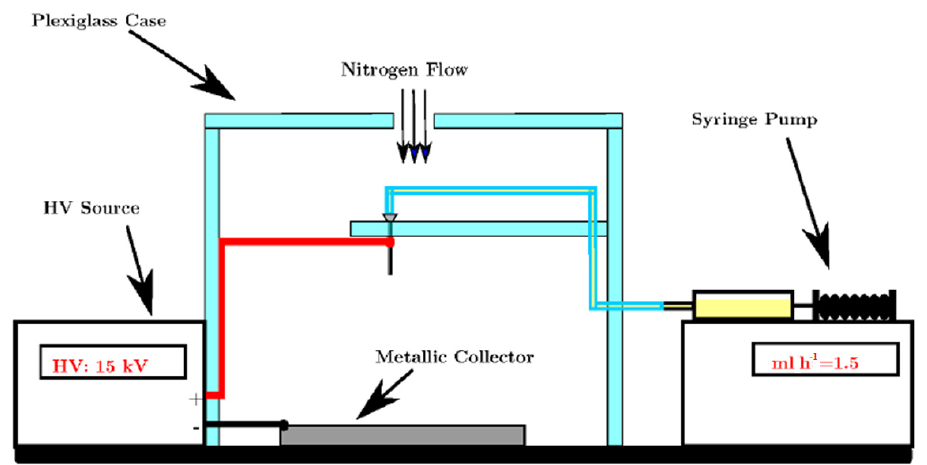
Figure 1. Schematic representation of electrospinning apparatus.